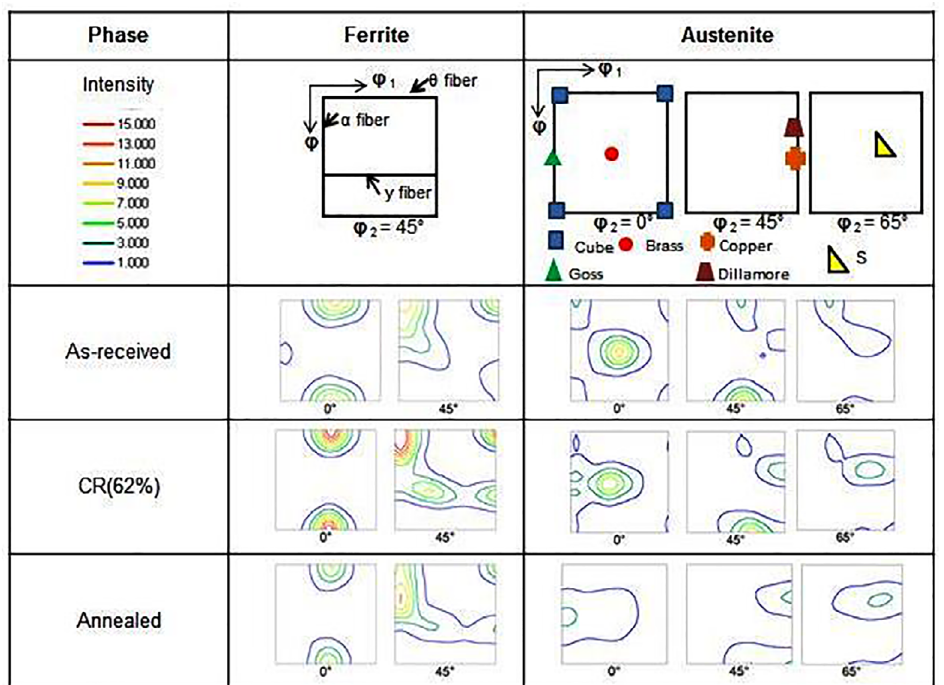
Figure 6. Crystallographic microtexture of duplex stainless steels S32304 of the samples as received, cold rolled and